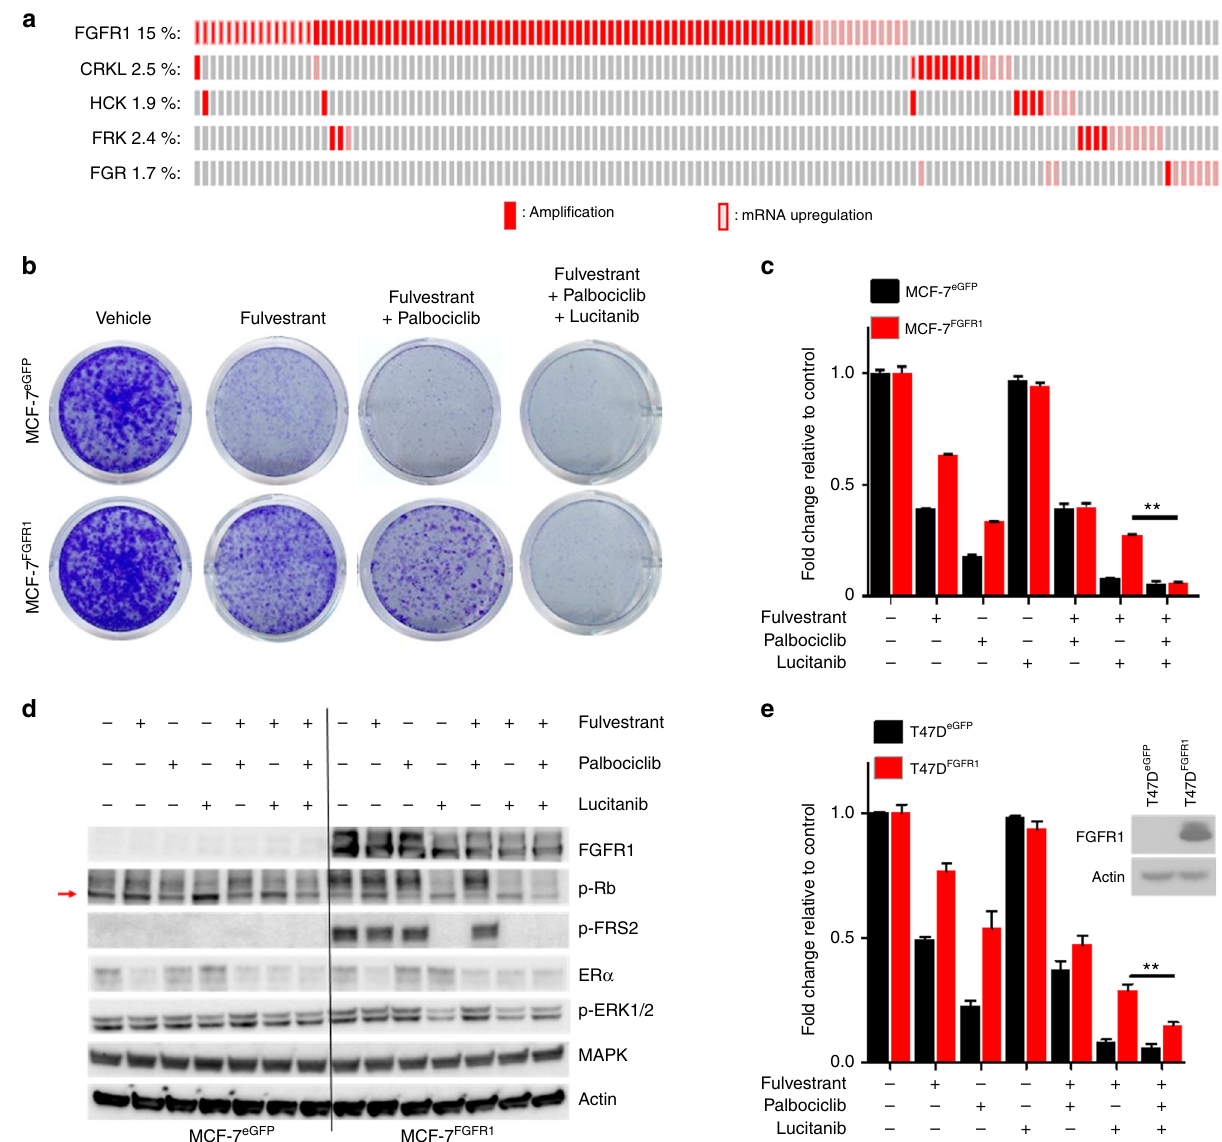
Fig. 2 FGFR1 overexpression confers resistance to fulvestrant and palbociclib. a Tile plot of ER + breast cancers in TCGA (Cell 2015) with ampli fi cation and/ or mRNA upregulation of FGFR1 , CRKL , HCK , FRK , and FGR . b – d MCF-7 eGFP and MCF-7 FGFR1 cells were seeded in 6-well plates in full media supplemented with 2 ng/mL FGF2 and treated with vehicle (DMSO), 1 μ M fulvestrant, or 1 μ M fulvestrant plus 1 μ M palbociclib ± 1 μ M lucitanib. Drugs and media were replenished every 3 days. After 14 days, monolayers were stained with crystal violet and analyzed as described in Methods. Quanti fi cation of the integrated intensity values as fold change relative to vehicle-treated controls are shown ( c ) (** p < 0.01 vs. controls, Student ’ s t -test). Cell lysates were subjected to immunoblot analyses with the indicated antibodies ( d ). e T47D eGFP and T47D FGFR1 cells were seeded in 6-well plates in full media supplemented with 2 ng/mL FGF2 and treated with vehicle (DMSO), 0.5 μ M fulvestrant, or 0.5 μ M fulvestrant plus 0.5 μ M palbociclib ± 1 μ M lucitanib. Drugs and media were replenished every 3 days. After 14 days, plates were washed and stained with crystal violet; imaging intensity was quanti fi ed by spectrophotometric detection. Quanti fi cation of the integrated intensity values as fold change relative to vehicle-treated controls are shown (** p < 0.01 vs. controls, Student ’ s t -test). Lysates from T47D cells stably transduced with an FGFR1 expression vector were subjected to immunoblot analysis with FGFR1 and actin antibodies (on top-right of the